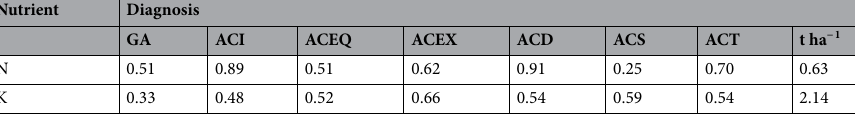
Table 6. Accuracy of nutritional diagnosis for the nutrient potassium and nitrogen for DRIS norms in banana ( Mussa spp). GA global accuracy, ACI accuracy measurement of true diagnoses for insufficiency, ACEQ accuracy measurement of true diagnoses for equilibrium, ACEX accuracy measurement of true diagnoses for excess, ACD accuracy measurement of true diagnoses for deficiency, ACS accuracy measurement of true diagnoses for sufficiency, ACT accuracy measurement of true diagnoses for